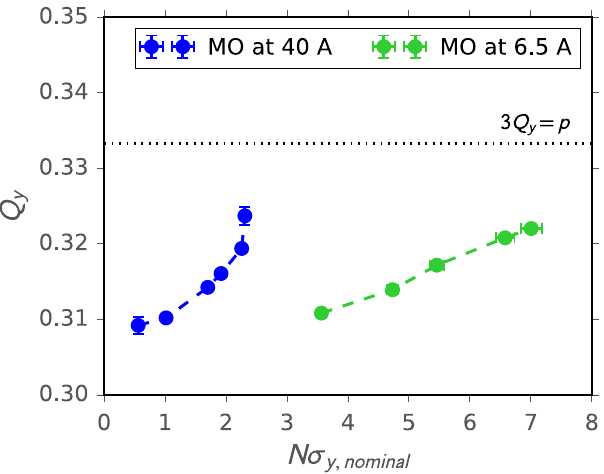
FIG. 15. Measured natural vertical tunes vs vertical excitation amplitudes for measurements with ac dipole and Landau octu- poles powered at 40 A (blue) and 6.5 A